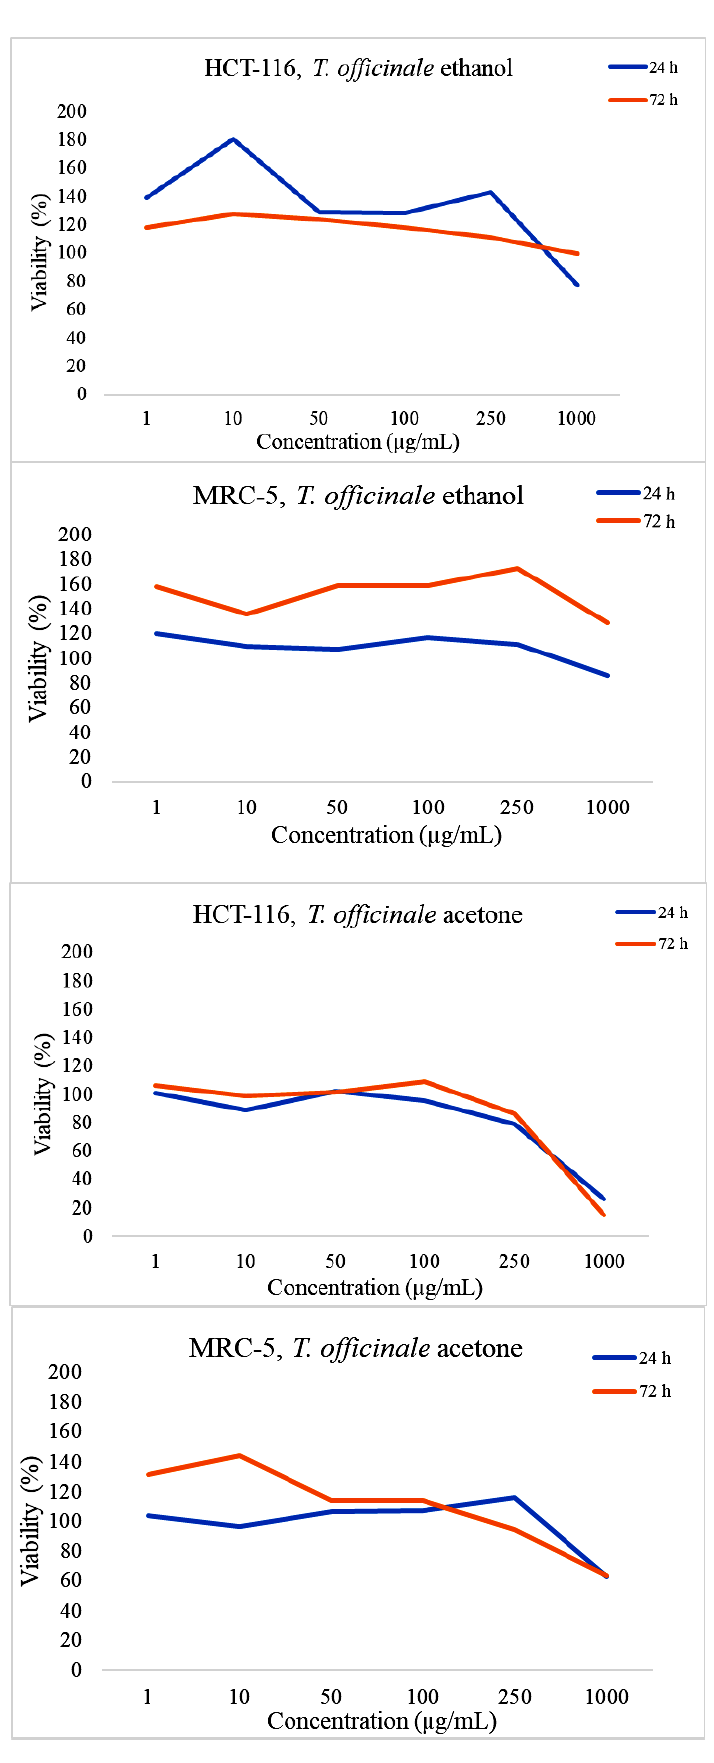
Figure 6. Cell viability (%) after treatment with ethanol and acetone extract of T.